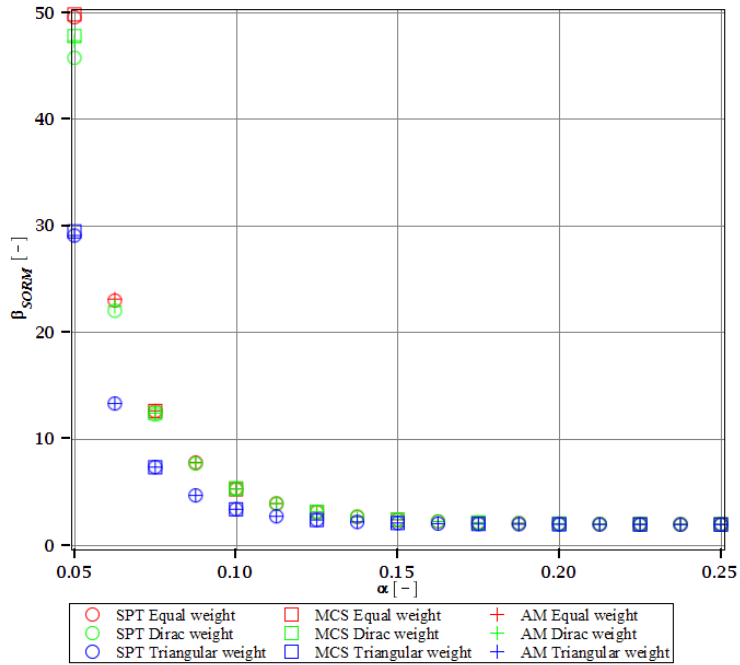
Figure 13. Reliability index of the corrugated I-beam for different types of weights according to the second-order reliability method (SORM) — normal stress.